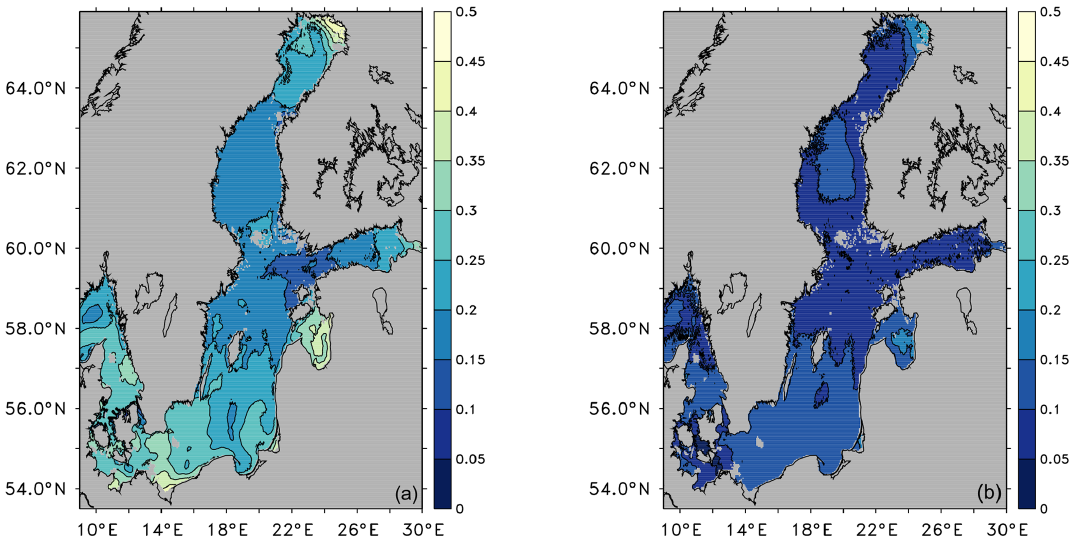
Figure 7. Uncertainty of ESL (m) for the period of 1970 to 1999 for the RCM ensemble (a) and the GCM ensemble (b) . The uncertainty is defined here as the likely range (5% to 95% range of ensemble